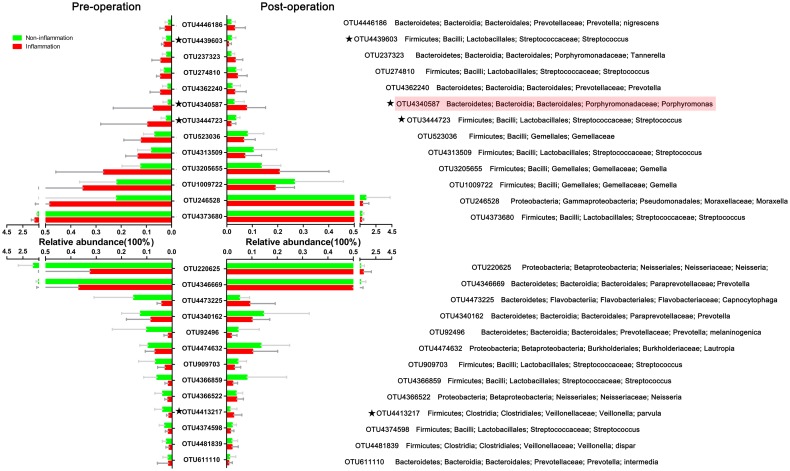
OTUs differing between the non-inflammation and inflammation groups before and after the operation.In total, 26 OTUs with relative abundances higher than 0.01% exhibited significant differences in mean relative abundances between the non-inflammation and inflammation groups before the operation (Mann-Whitney test, P < 0.05). Bars indicate means ± SEM relative abundances. The upper part of the diagram shows that the levels of 13 pre-operative OTUs were higher in the inflammation group, and the lower part shows that another 13 OTUs were lower. The relative abundance of four OTUs marked with the stars (★) were significantly different between the inflammation and non-inflammation groups both pre- and post-operation.A higher proportion of OTU4340587, corresponding to Porphyromonas sp. (with the pink shadow), was found in inflammation subjects than in non-inflammation subjects both pre- and post-operation.